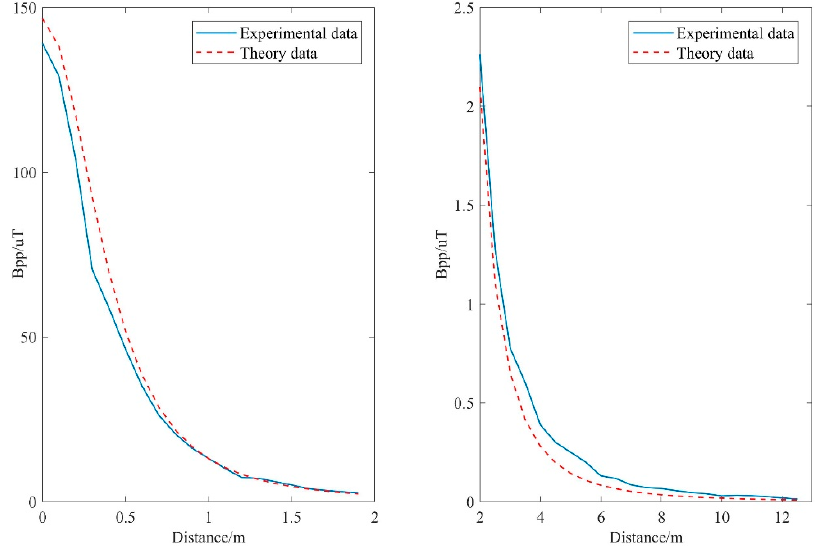
Figure 13. Attenuation of electromagnetic propagation in experiment and theory.